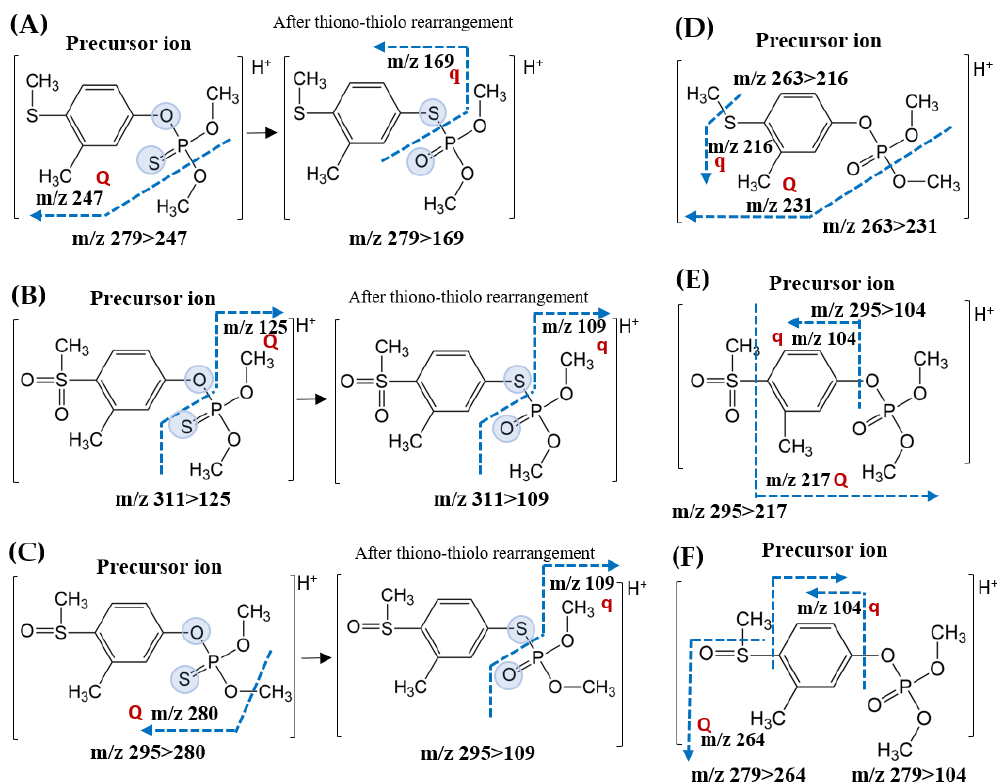
Figure 2. Predicted MS / MS fragmentation scheme of the precursor ions, induced by optimized collision energies: ( A ) fenthion, ( B ) fenthion sulfone, ( C ) fenthion sulfoxide, ( D ) fenthion oxon, ( E ) fenthion oxon sulfone, and ( F ) fenthion oxon sulfoxide.